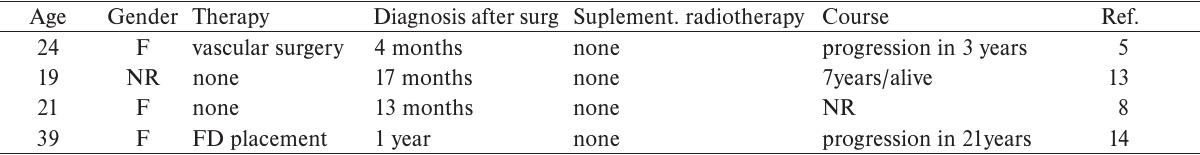
note: F = female, surg = surgery, NR = not reported, FD = flow